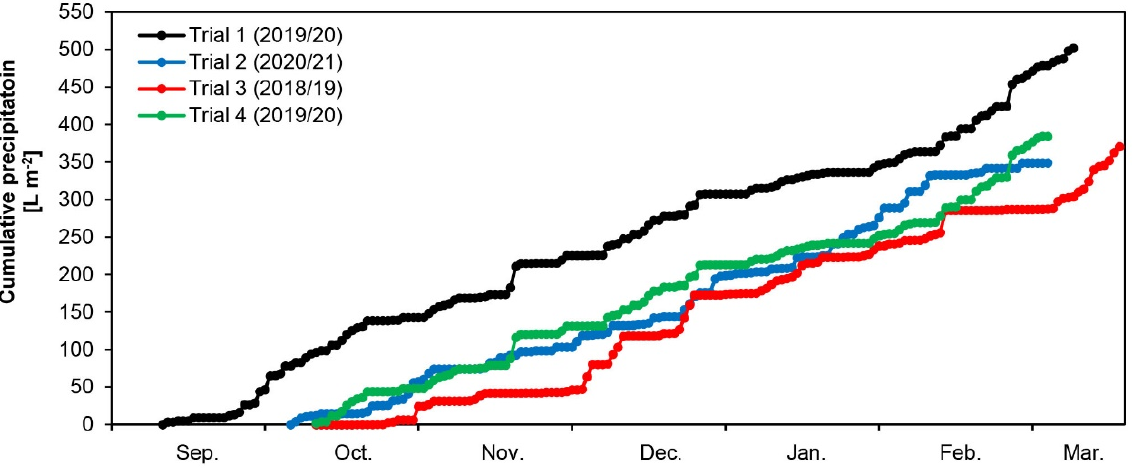
Figure 2. Cumulative precipitation from spinach harvest until completion of the trials in March (weather station Borken-Westphalia, Deutscher Wetterdienst, Germany).